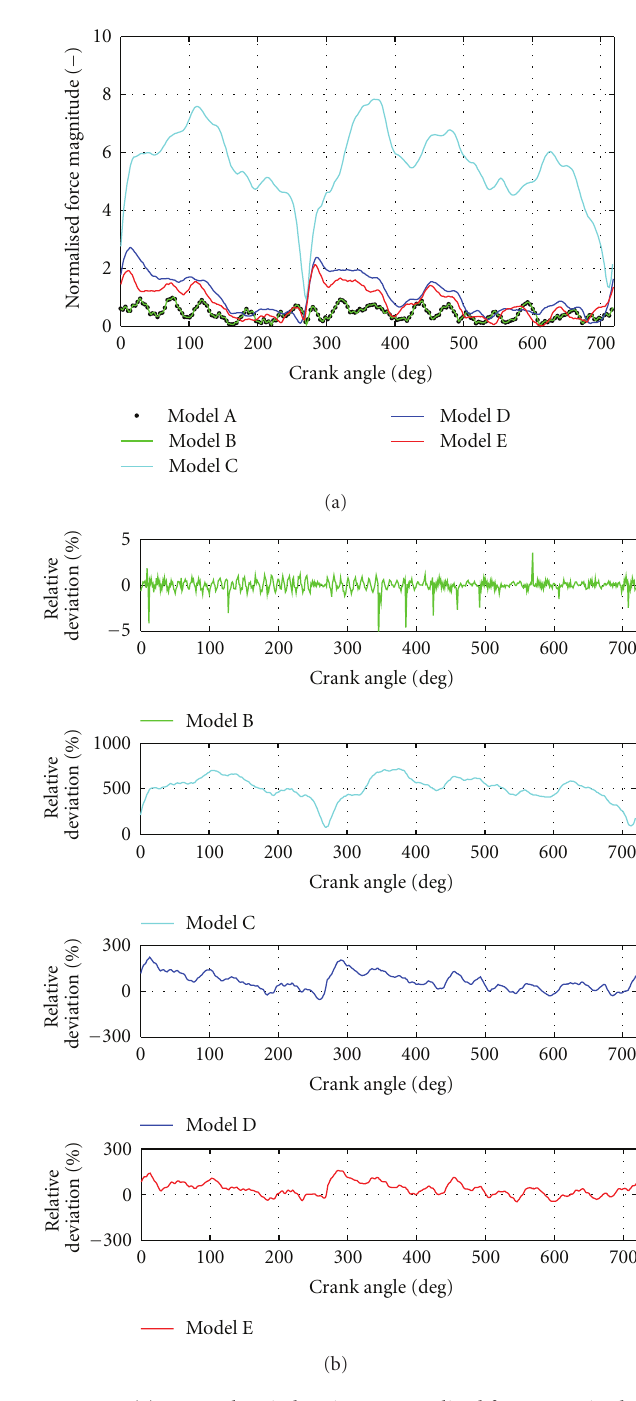
Figure 7: (a) External main bearing 2 normalized force magnitude; (b) relative percentage deviations of Models B, C, D, and E,